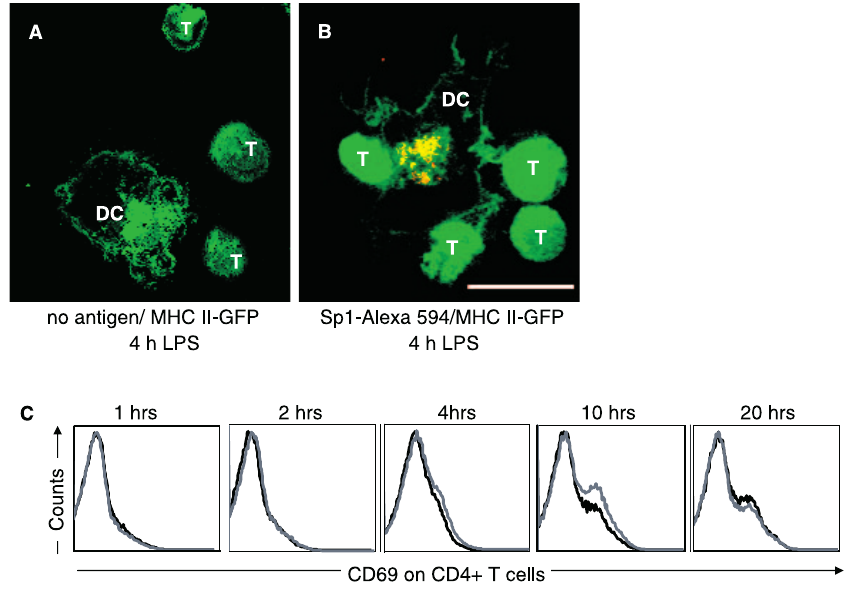
Figure 4. Interaction of DCs with Naı¨ve CD4 þ T Cells iDCs expressing MHCII-GFP and CFSE-labeled CD4 þ T cells were used for live cell imaging of DC/T-cell immune interactions. Live fluorescent confocal microscopy imaging was performed at 4 h of LPS treatment. CD4 þ T cells are indicated by a ‘‘ T ’’ . (A) DCs left untreated. (B) iDCs were pulsed for 30 min with Sp1 (500 l g/ml) and then treated with LPS. Scale bar, 10 l m. (C) iDCs were treated with Sp1 (100 l g/ml) for 45 min or left untreated before incubation with naı¨ve CD4 þ T cells in the presence of LPS (100 ng/ml). CD69 surface expression on CD4 þ T cells was analyzed at indicated time points. Black line, non-Sp1-treated DCs; gray line, Sp1-treated DCs.